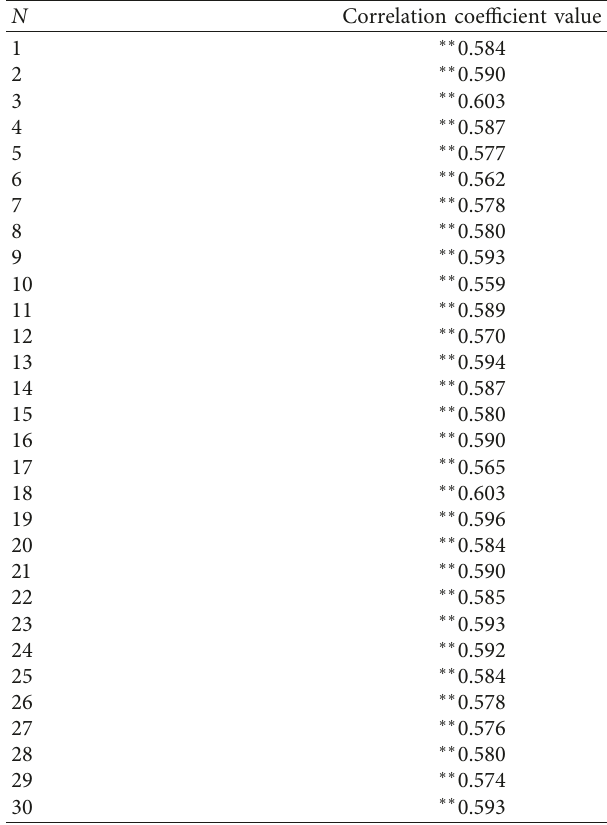
Table 5: Means and standard deviations of students’ scores on the psychological resilience scale.